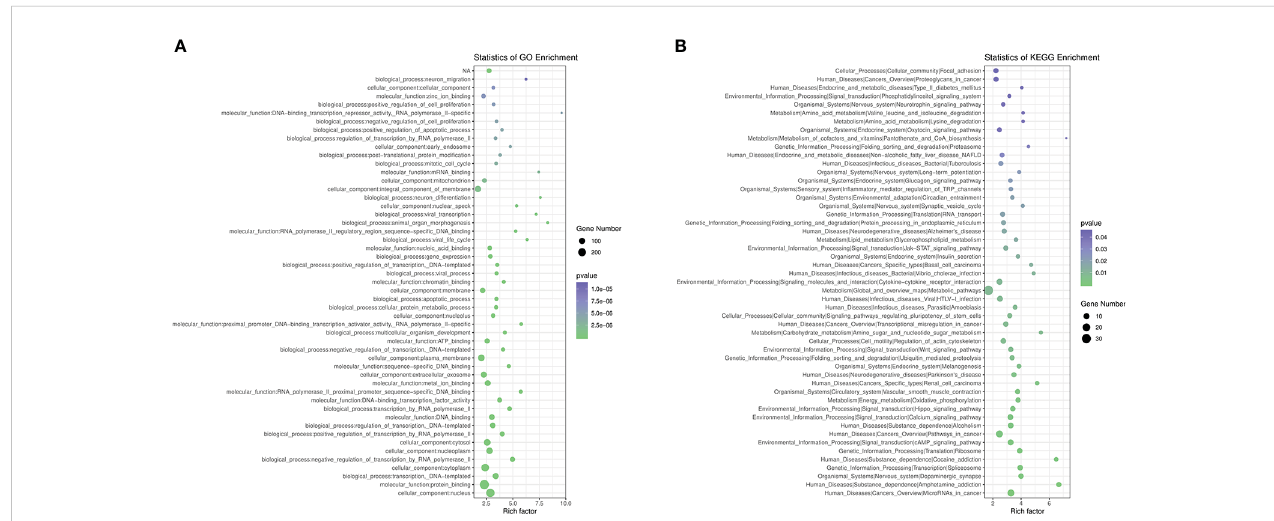
FIGURE 3 Pathway Analysis on DMR-related genes. (A) , GO analysis of DMR-related genes. (B) , KEGG analysis of DMR-related